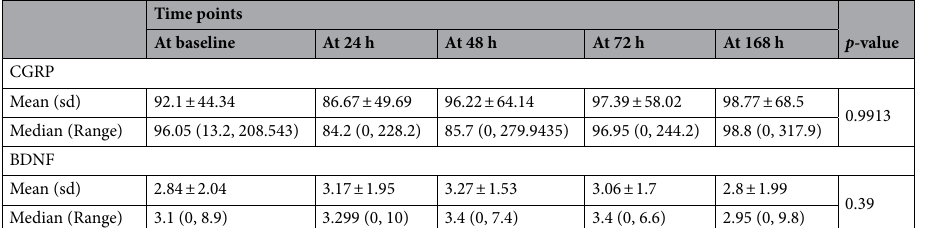
p -valueAt baseline